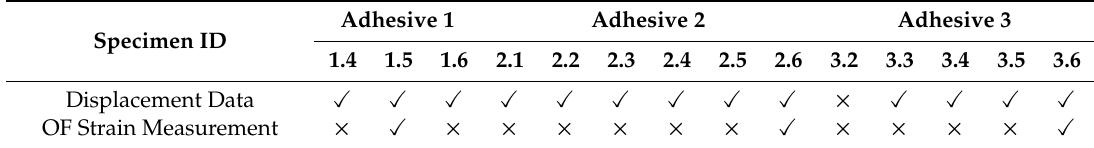
Table 2. Experimental program.